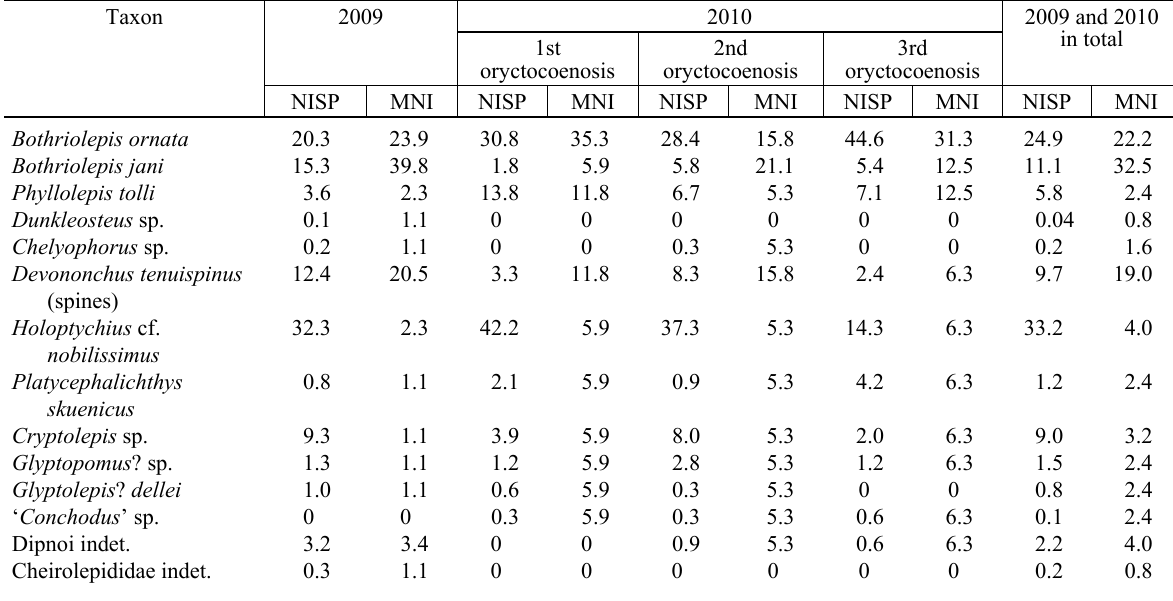
Table 3. Comparison of the oryctocoenoses by the number of identified specimens, NISP (%) and the minimum number of individuals, MNI